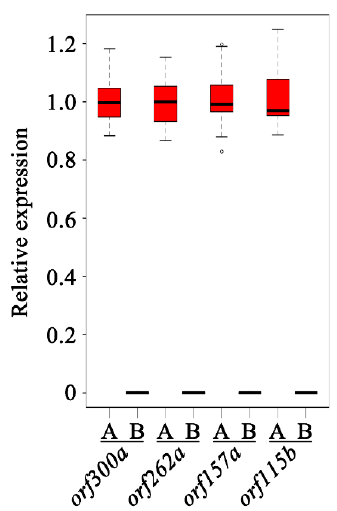
Figure 6. Transcriptional level of four 138A specific ORFs ( orf262a , orf300a , orf157a , orf115b ) in CMS line 138A and maintainer line 138B. Expression value the four ORFs in 138A was set as 1. UBI-3 was employed as the internal control. ( A ) and ( B ) represented lines 138A and 138B, respectively.